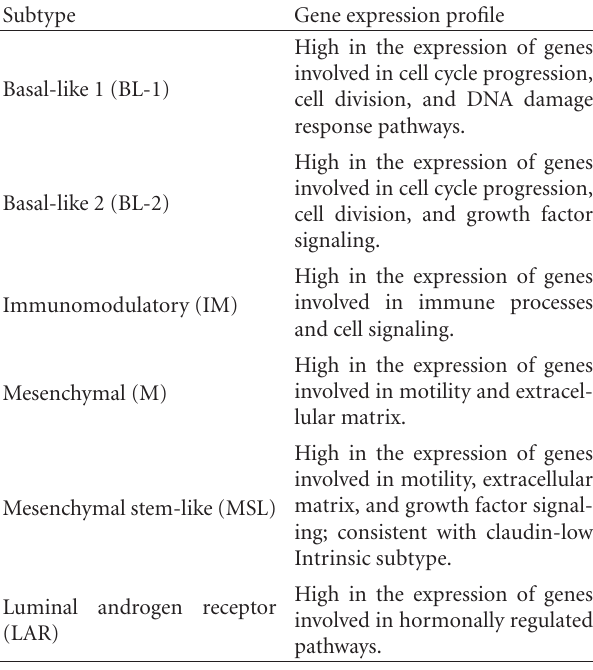
Table 2: Six subtypes of triple negative breast cancer based on gene expression